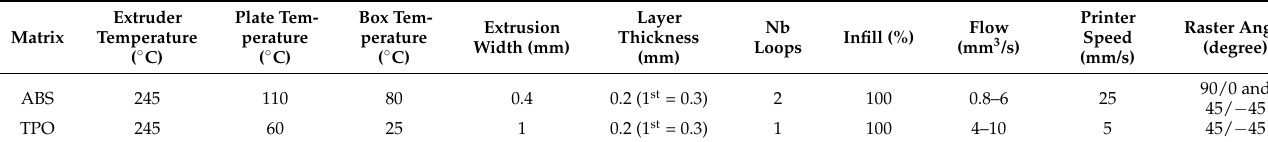
Table 2. Main printing parameters used for the preparation of the 3D printed specimens.